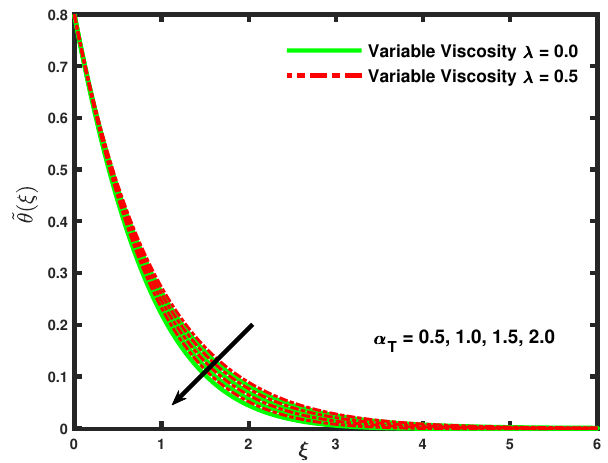
Figure 5. The influence of thermal relaxation parameter α T on Temperature profile.